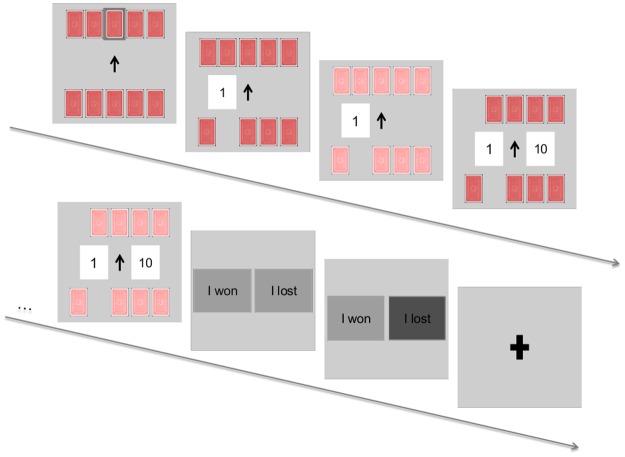
Experimental design.